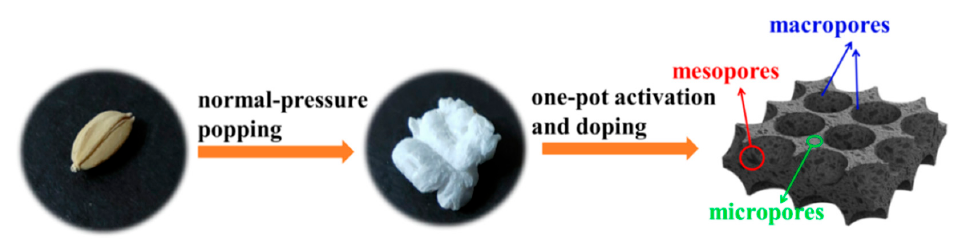
Figure 1. A schematic illustration of the preparation of nitrogen-doped hierarchical porous acti- vated carbon.